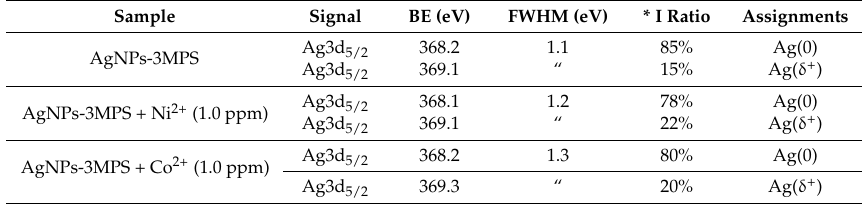
Table 2. High-resolution X-ray photoelectron spectroscopy (HR-XPS) Ag3d 5/2 metal core levels data collected on pristine AgNPs-3MPS and AgNPs-3MPS, in presence of 1 ppm of Ni and Co ions (binding energy (BE), full width half maximum (FWHM), atomic ratio, and assignments).